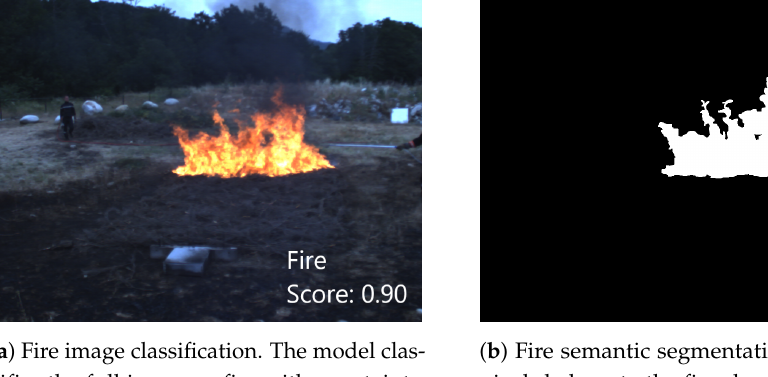
Figure 1. Example of wildfire image classification and